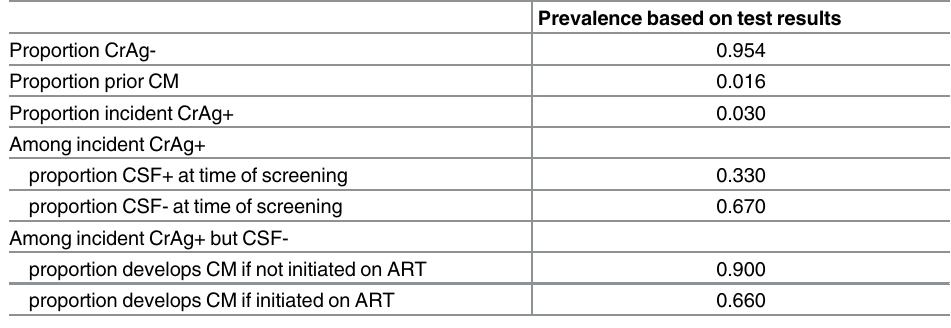
Table 1. Distribution of CrAg status in population.